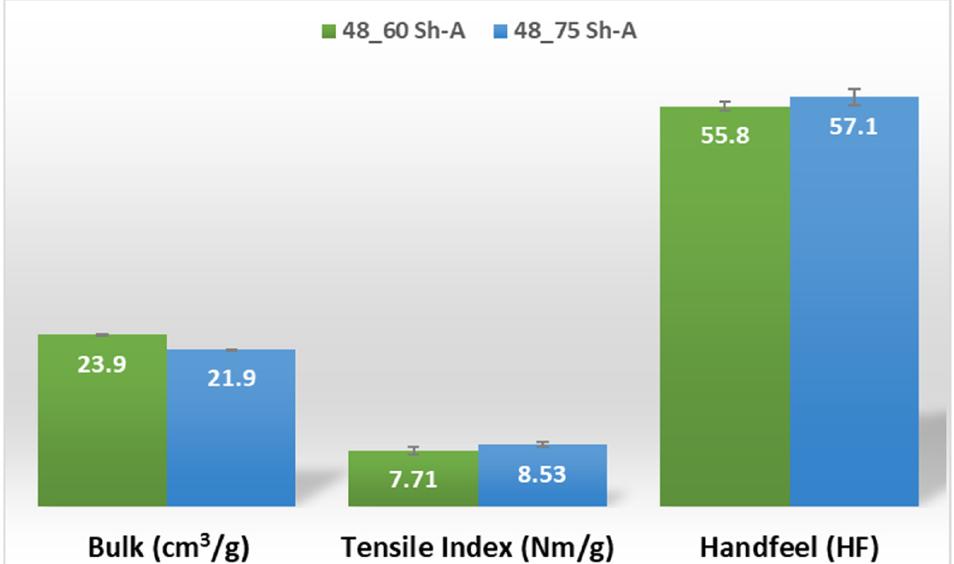
Figure 15. Bulk, tensile index, and handfeel results for micro embossing and configuration 3 rubber hardness conjugation.